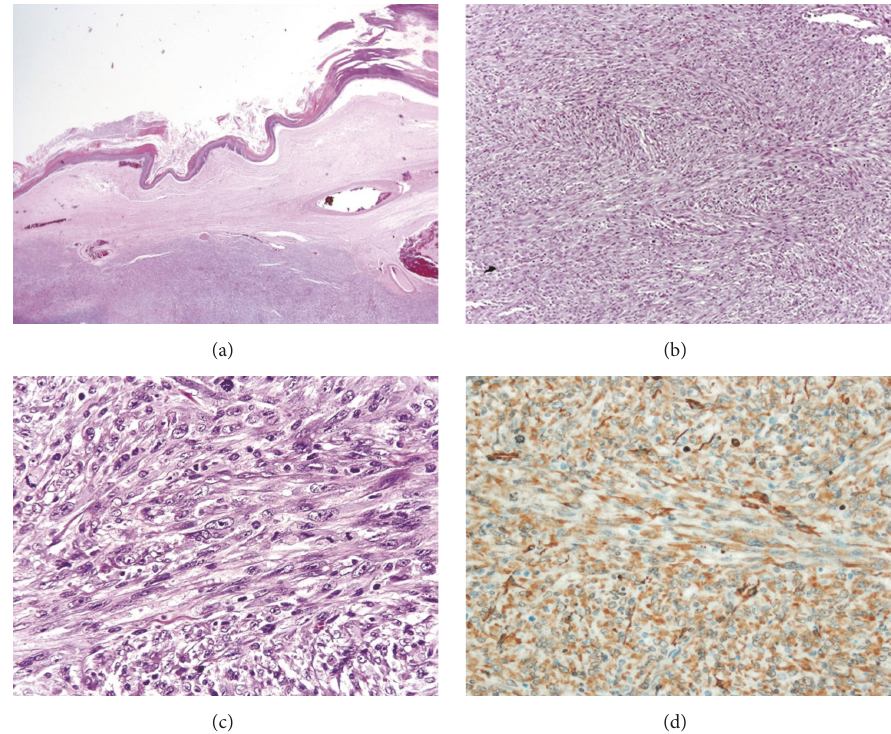
Figure 1: Leiomyosarcoma in mature cystic teratoma of ovary. (a) The cyst lined by keratinized squamous epithelium. Note the intramural sarcomatous component beneath the cyst lining (H&E, 1.25x). (b) Leiomyosarcoma showed intersecting fascicles of malignant spindle cells (H&E, 10x). (c) Leiomyosarcoma exhibited moderate to markedly atypical spindle cells with blunt-ended (or cigar-shaped) nuclei and eosinophilic fibrillar cytoplasm. Note numerous mitotic figures (H&E, 40x). (d) Leiomyosarcoma showed strong and diffuse positivity for smooth muscle actin (IHC stain,